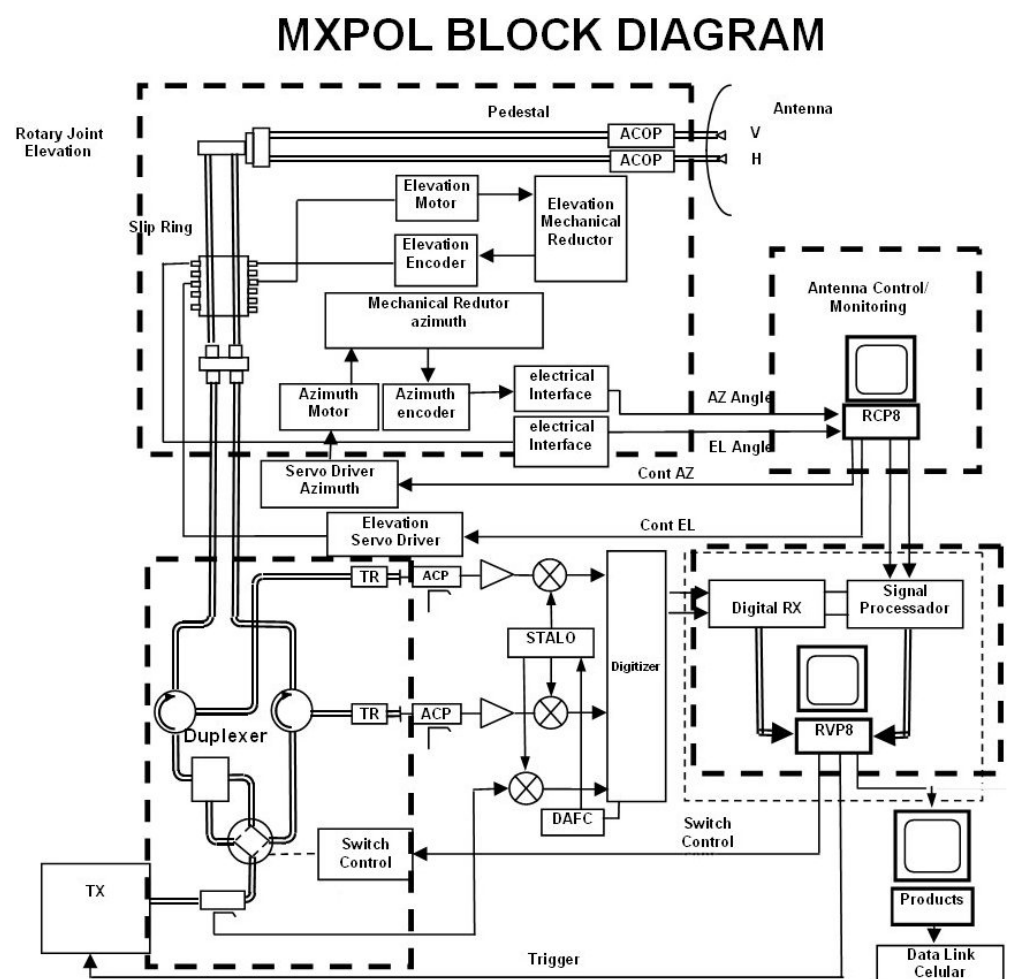
Fig. 1. Block diagram of the MXPOL weather radar.